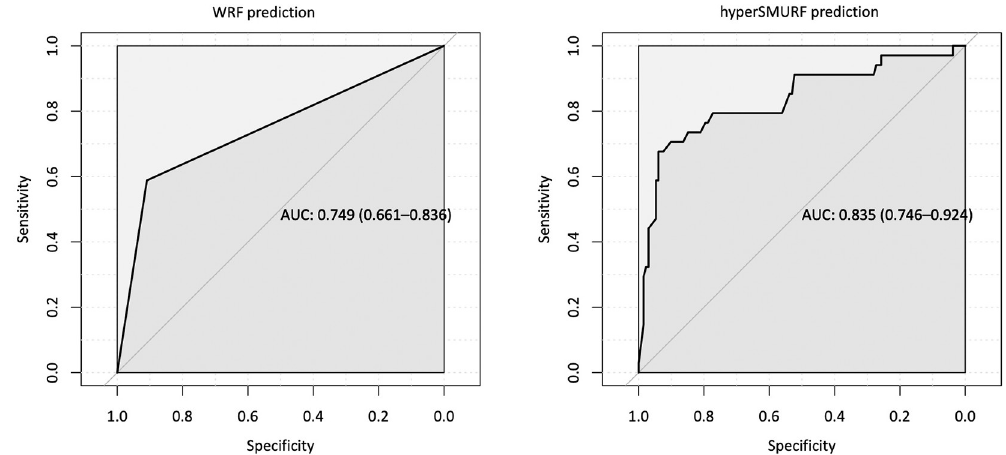
Fig 4. Receiver operating characteristic curves for the prediction of EI using weighted random forest (WRF, left) and hyper- ensemble of SMOTE under sampled random forests (HyperSMURF, right) methods. Areas under the curves are shown as the median and 95% confidence